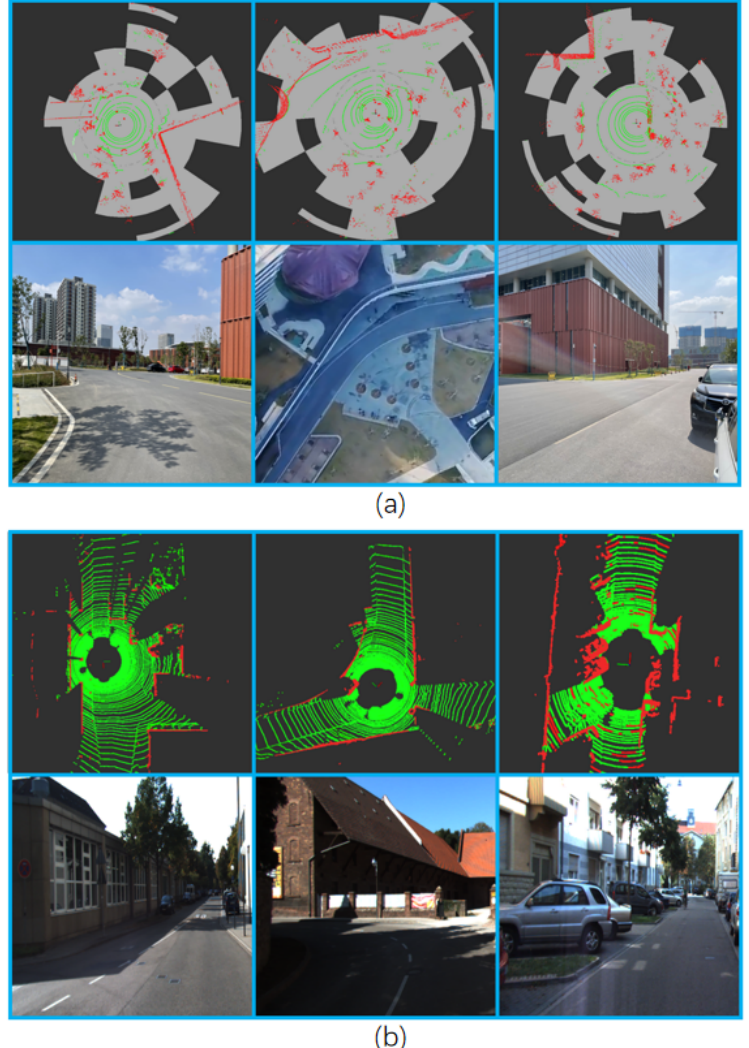
Figure 12. Results of traverse area detection experiment: The upper part of ( a , b ) is the segmented point cloud (the green part is the divided ground point cloud, the red part is the non-ground point cloud, and the gray part represents the bins described in Section 3.2.2), and the lower part is the corresponding